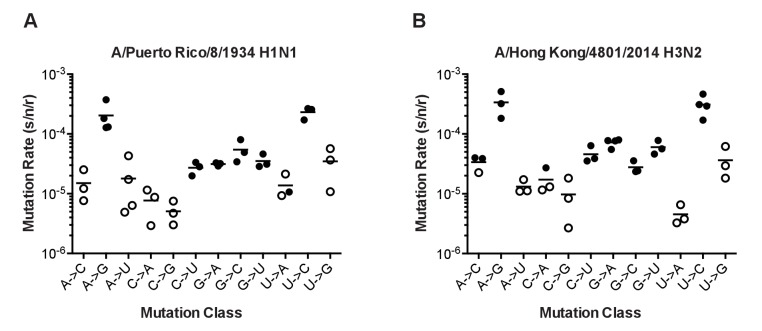
The mutation rates of influenza viruses replicated at 37°C.(A) Measurements of A/Puerto Rico/8/1934 H1N1 viruses encoding the 12 different mutant ΔHA-GFP constructs. (B) Measurements of viruses encoding the replication complex (PB2, PB1, PA, and NP) from A/Hong Kong/4801/2014 H3N2 and the remaining genes coming from A/Puerto Rico/8/1934 H1N1. Filled symbols represent measurements in which P0 is between 0.1 and 0.69. Open circles represent data with P0 between 0.7 and 0.95. Plotted data are in Figure 4—source data 1. Raw counts of green cells in positive wells for Hong Kong viruses are in Figure 4—source data 2. The arithmetic means are indicated on the graphs and the means and standard deviations reported in Supplementary file 2.DOI:
http://dx.doi.org/10.7554/eLife.26437.01210.7554/eLife.26437.013Figure 4—source data 1.Mutation rates for all twelve mutational classes for PR8 and Hong Kong viruses as measured by fluctuation test.DOI:
http://dx.doi.org/10.7554/eLife.26437.01310.7554/eLife.26437.014Figure 4—source data 2.Raw data for all experiments with Hong Kong viruses showing number of wells with n green cells (n = 0–10).